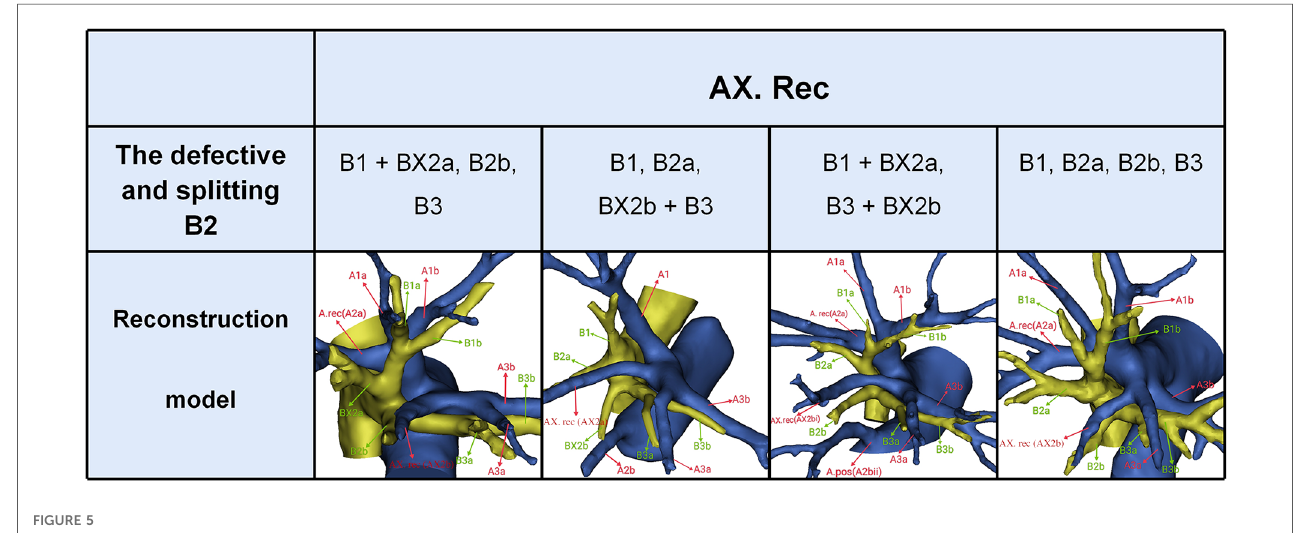
FIGURE 5 The distribution of AX. rec in the defective and splitting B2 type.